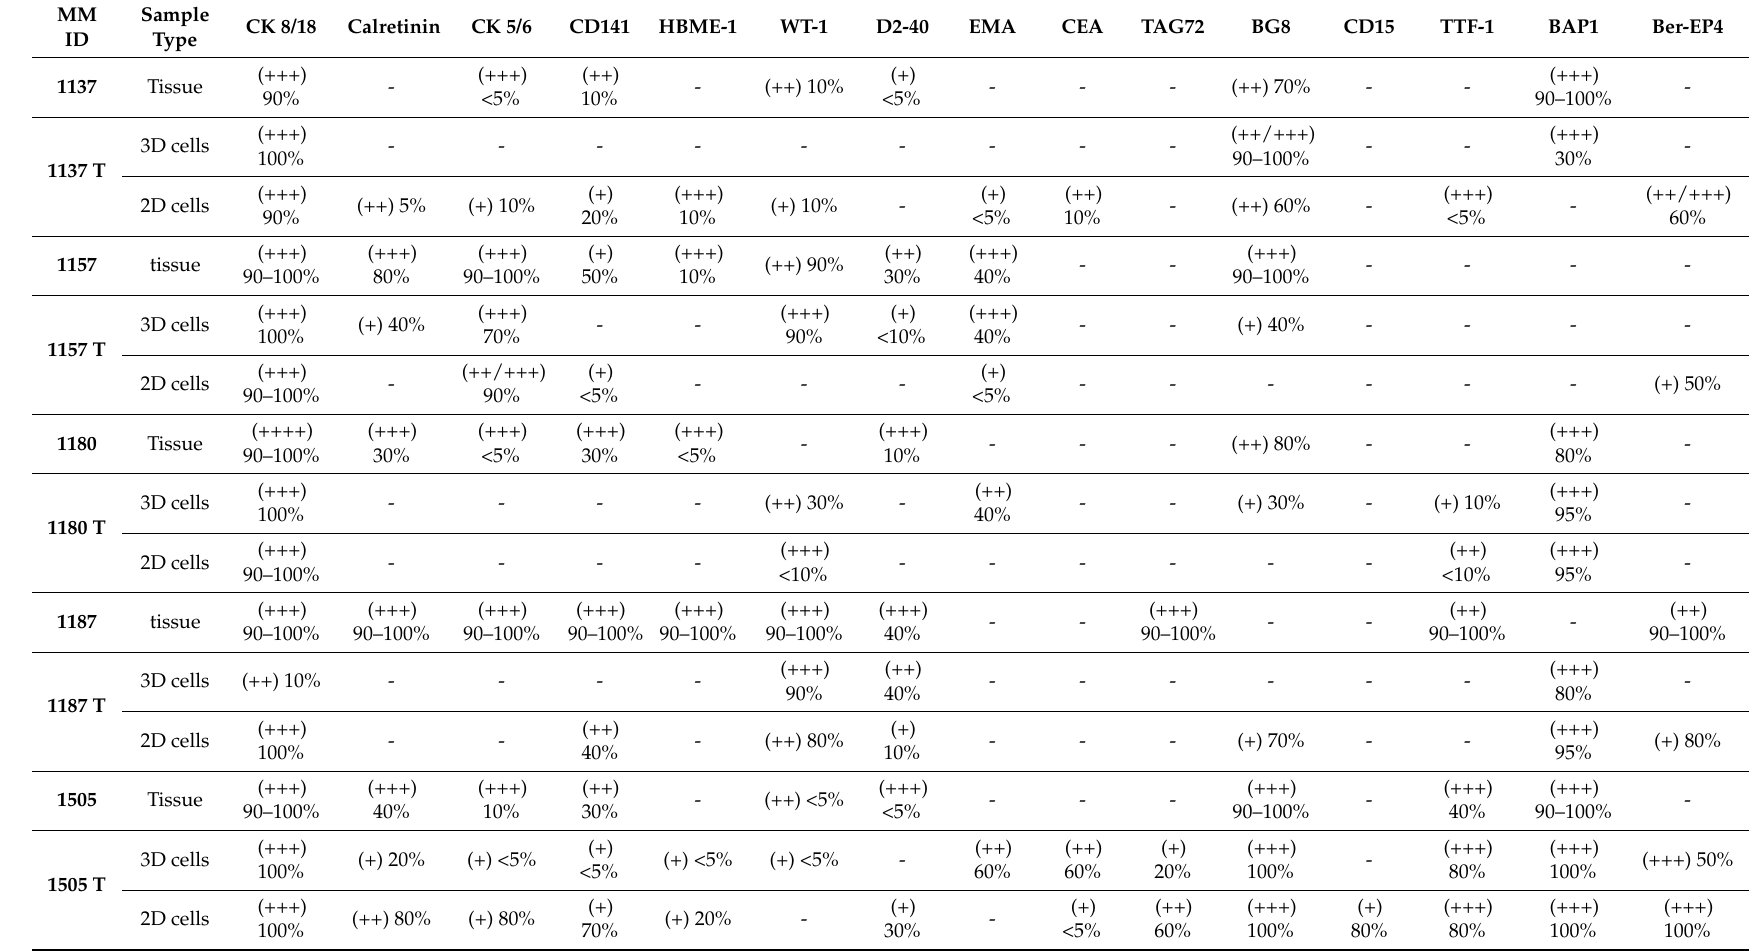
Table 1. Mesothelioma biomarker